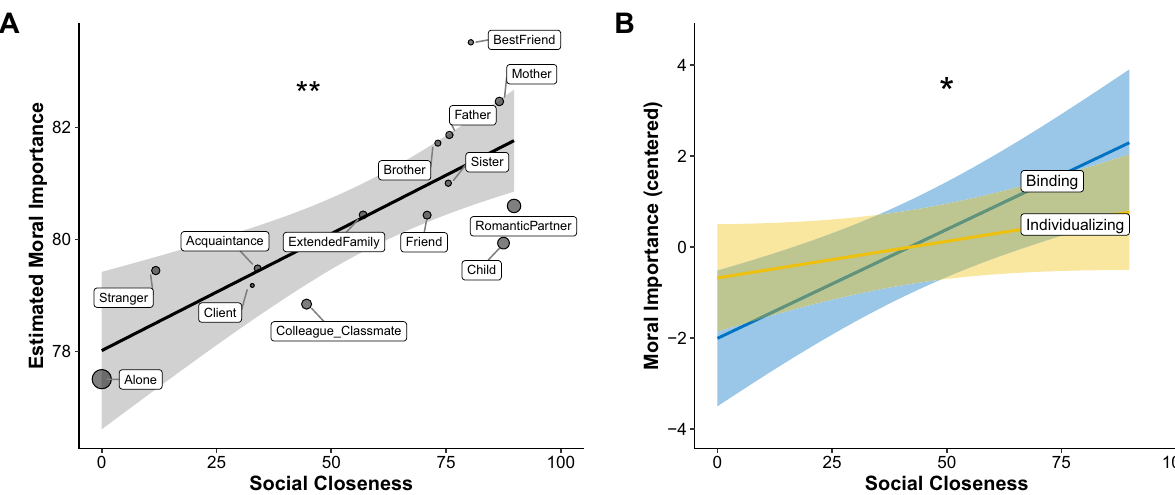
Fig. 1 The relationship between moral importance and social closeness. A The estimated importance participants ( n = 1166) in each relational context afforded moral values plotted against the average social closeness of that relationship (obtained from a separate sample, n = 94). Black line shows the best fi t line using ordinary least squares (OLS); ribbon = SEM; dot size re fl ects group size (range: 13 — client to 806 — alone). B The relationship between average social closeness and moral importance of binding and individualizing values, with both value sets centered on their respective means. Ribbons = SEM. **Slope signi fi cant, B = 0.03, SE = 0.01, p < 0.001; *Difference of slopes signi fi cant, B = 0.027, SE = 0.014, p = 0.048. Source data are provided as a Source data fi